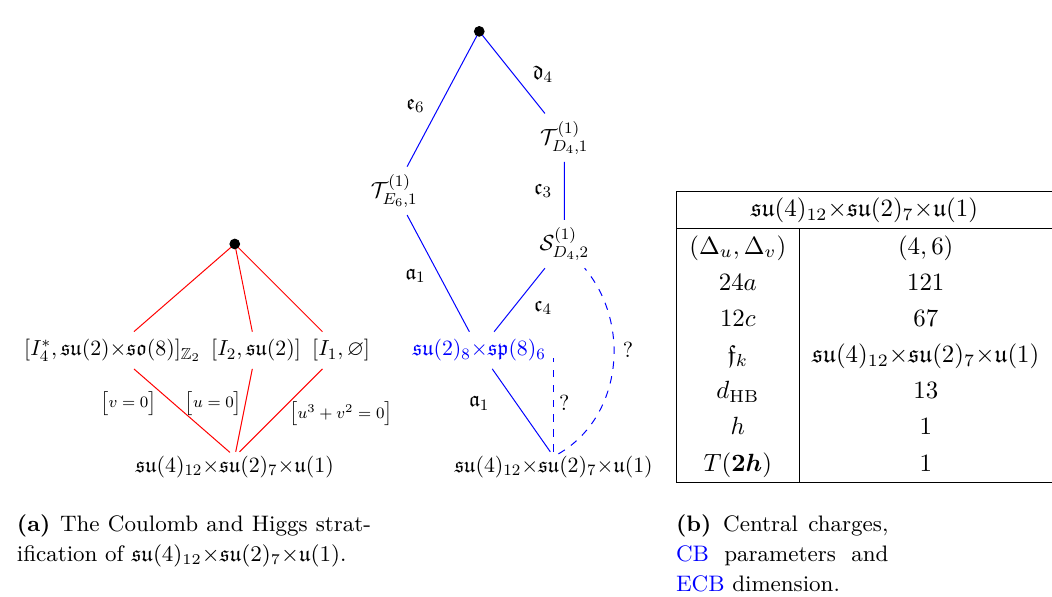
Figure 23. Information about the su (4) 12 × su (2) 7 × u (1)